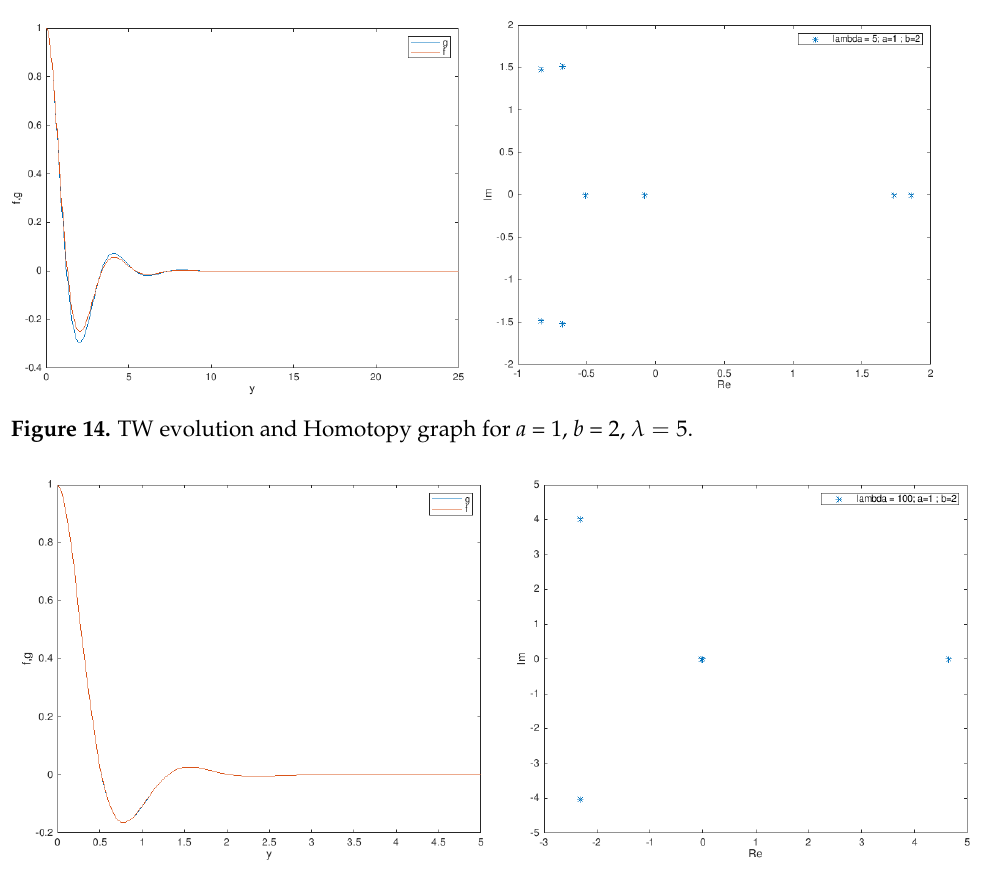
Figure 15. TW evolution and Homotopy graph for a = 1, b = 2, λ = 100. For λ → ∞ and a (cid:54) = b in the same order a (cid:31) b , the homotopy graph tends to